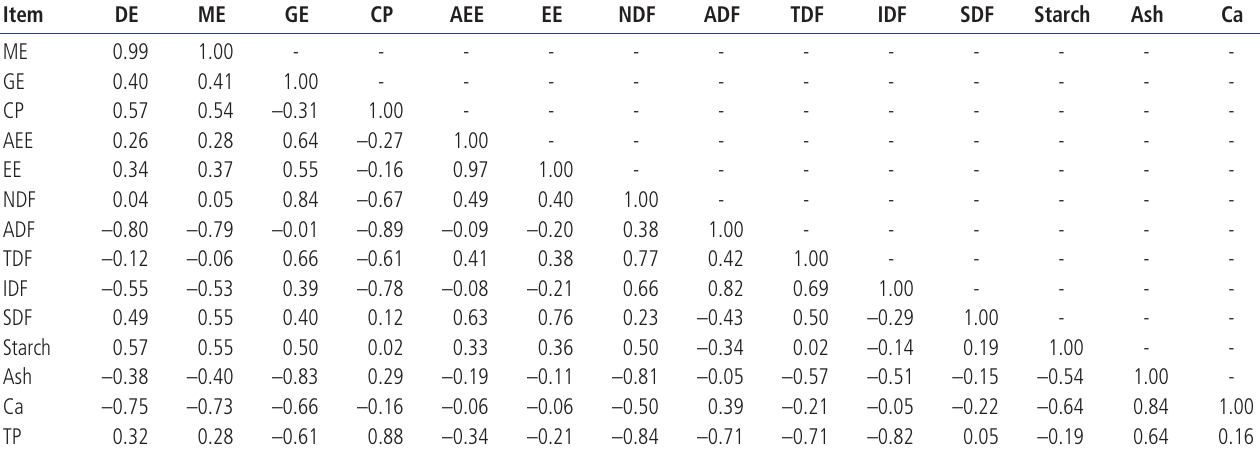
Table 6. Correlation coefficients (r) between chemical constituents and energy values of the 10 corn germ meal samples 1) Item DE